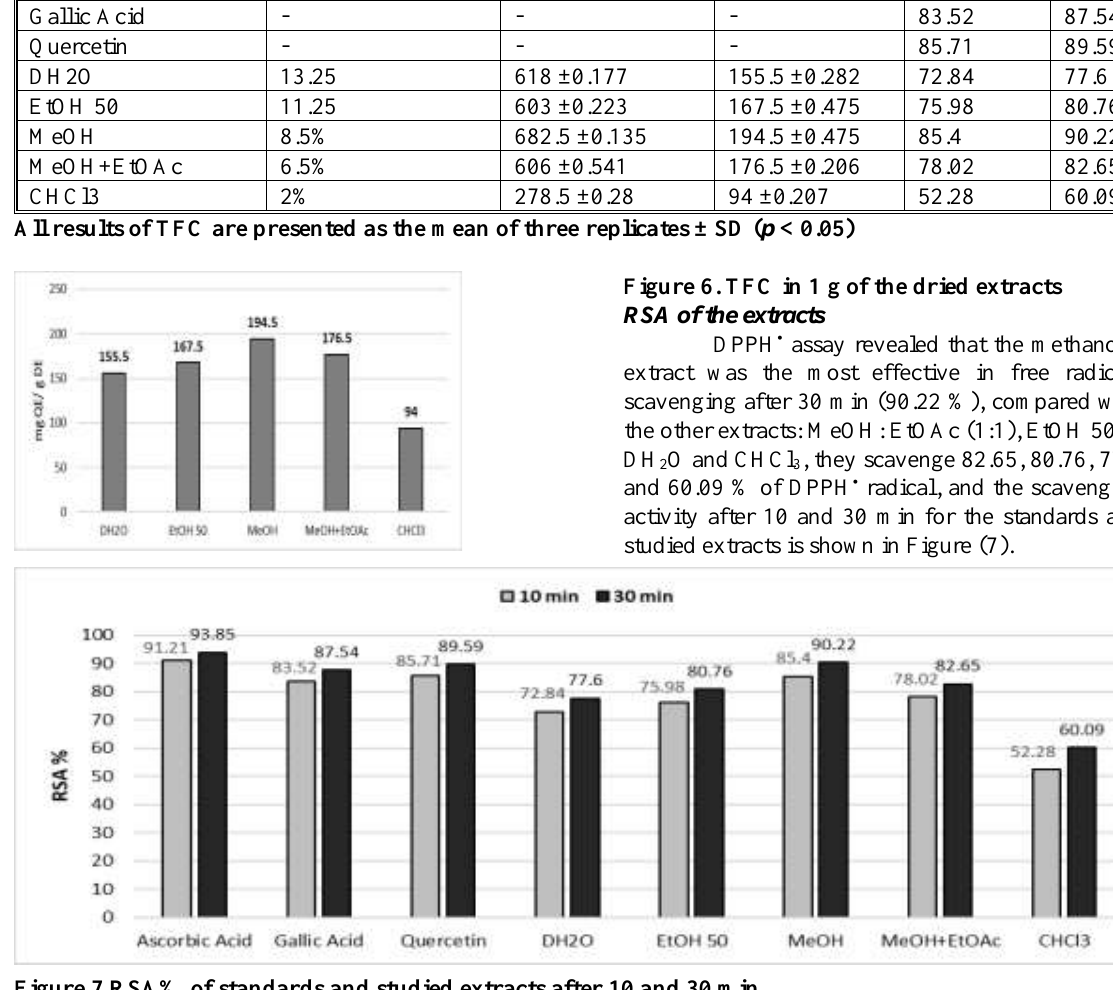
Figure 7.RSA% of standards and studied extracts after 10 and 30 min The DPPH • scavenging activity after 10 and 30 min, total phenolic and flavonoid contents of the extracts is shown in Table (5).